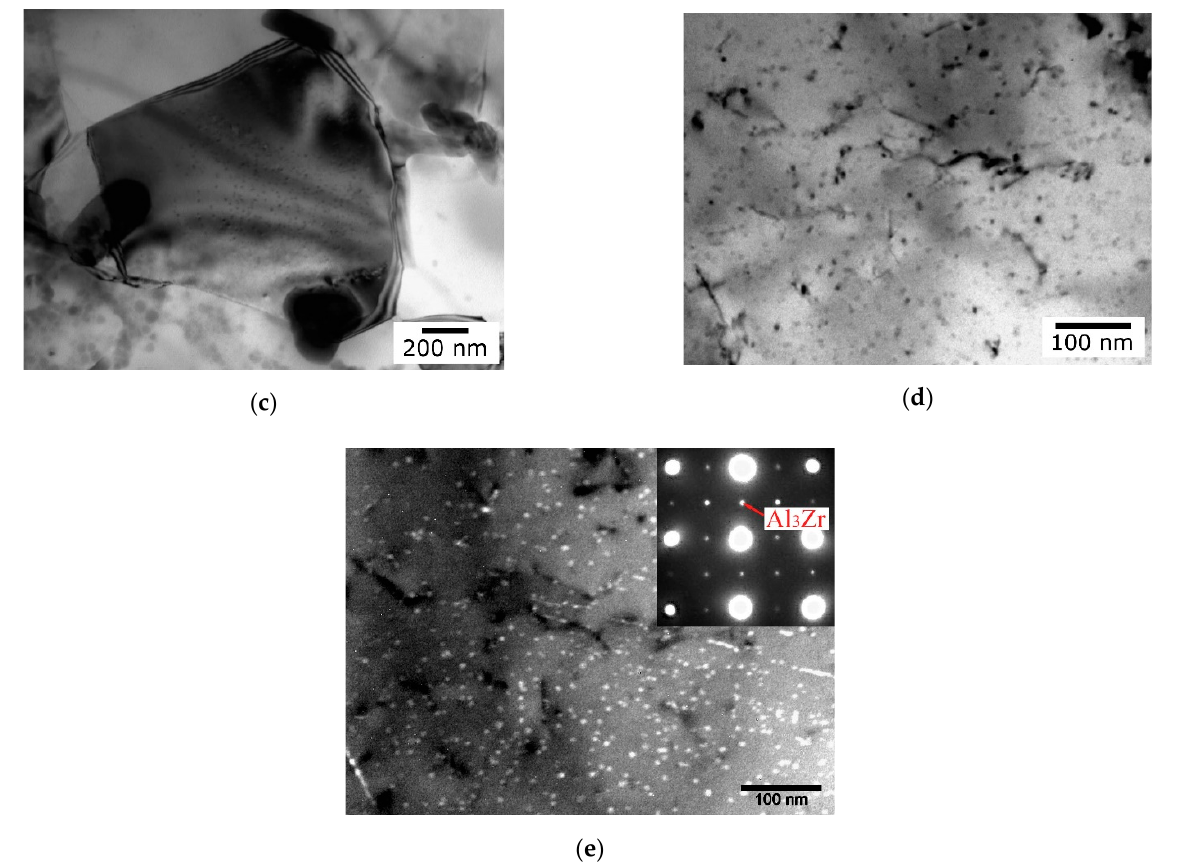
Figure 5. TEM structure of wire alloy ACZ (strip) and after annealing according to ( a , b ) S350 °C and ( c – e ) S450 °C regimes, ( a – d ) bright field, ( e ) dark field and diffraction patterns.